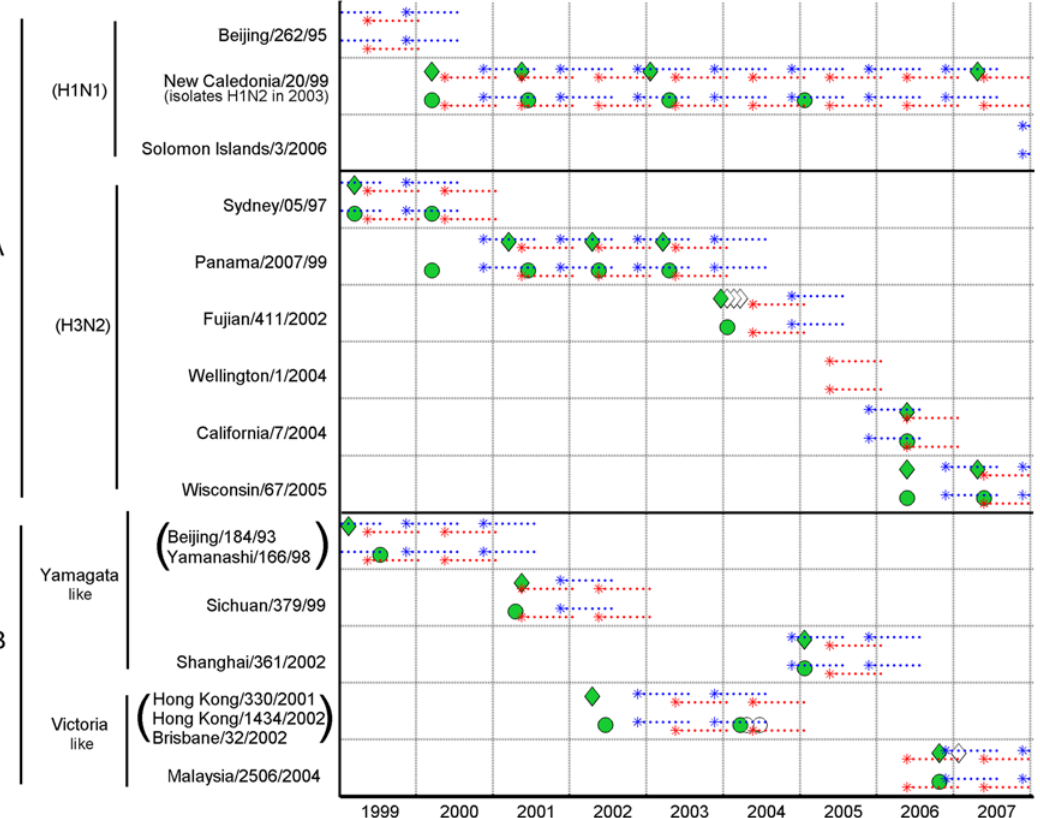
Figure 3. Matching success of vaccine strategies against strains of influenza viruses isolated monthly from 1999 to 2007 in Bele´m and Sa˜o Paulo. The different categories of influenza strains considered in the study period are indicated on the vertical axis, sorted by influenza subtype (influenza A) and lineage (influenza B) and identification date. Time is measured on the horizontal axis. Strains isolated each month are represented by green diamonds for Bele´m, and green circles for Sa˜o Paulo (blank symbols represent subsequent isolations of the same strain in the same season, and therefore were not considered for the analysis). Stars represent the first month of the period of vaccination-induced protection, while the following dotted lines represent the remaining months of protection. Red lines correspond to historical vaccination strategy adopted by the Brazilian authorities (i.e. relying on the southern hemisphere vaccine recommendations and schedule). Blue lines represent a hypothetical scenario whereby the northern hemisphere vaccination recommendations and schedule are used in both cities. The rate of successful matches between vaccines and circulating strains is quantified by the overlap between vaccine data (blue or red lines, depending on the scenario analyzed) and actual virus isolations (green circles and diamonds) through this